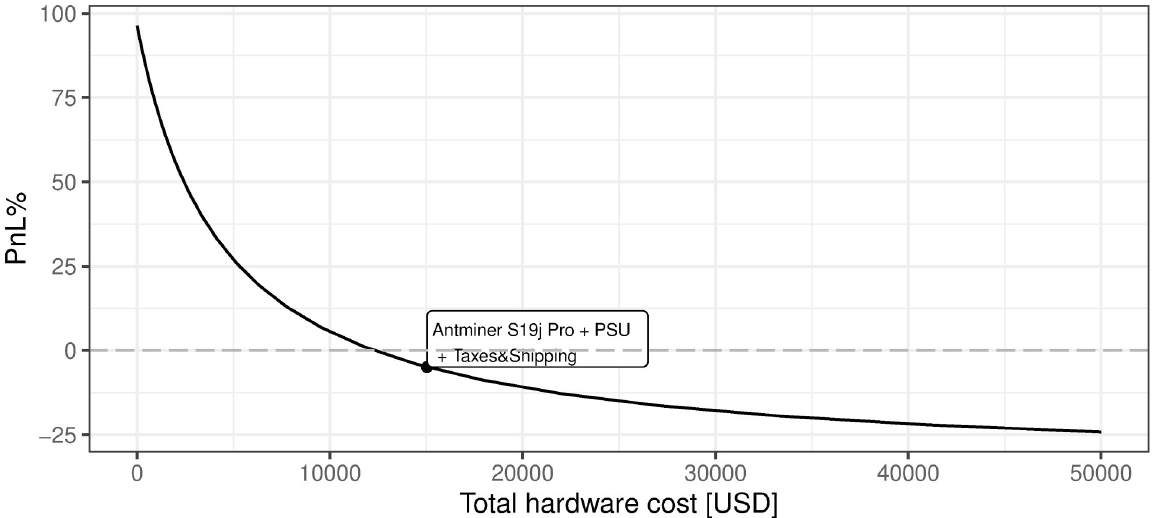
Fig 22. BTC mining profitability (PnL%) for different cost of hardware. Note: PnL%, calculated according to the formula 6. Hypothetical hardware cost ranges from 0 up to 50000 USD per unit. Since the Antminer S19J Pro is defined as the most efficient for mining purposes (in terms of price vs. power consumption and hash rate), its cost is analyzed on the charts. The market value point describes the current state of market mining efficiency assuming the parameter outlined in the section Values of variables as of 2021/12/03. Source: own calculations based on data described in section Crucial assumptions and